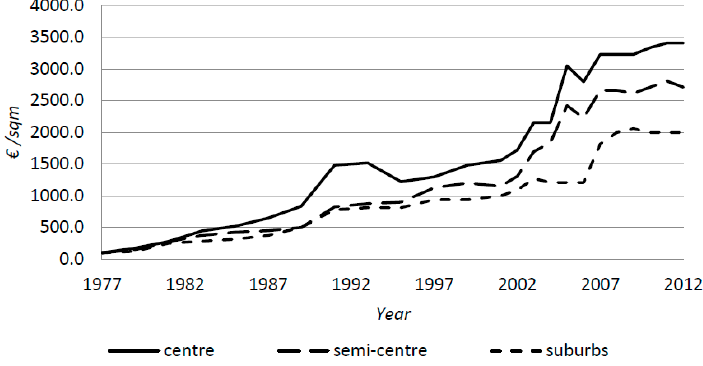
Figure 1. Trend in property values in Naples from 1977 to 2012 for different urban areas.